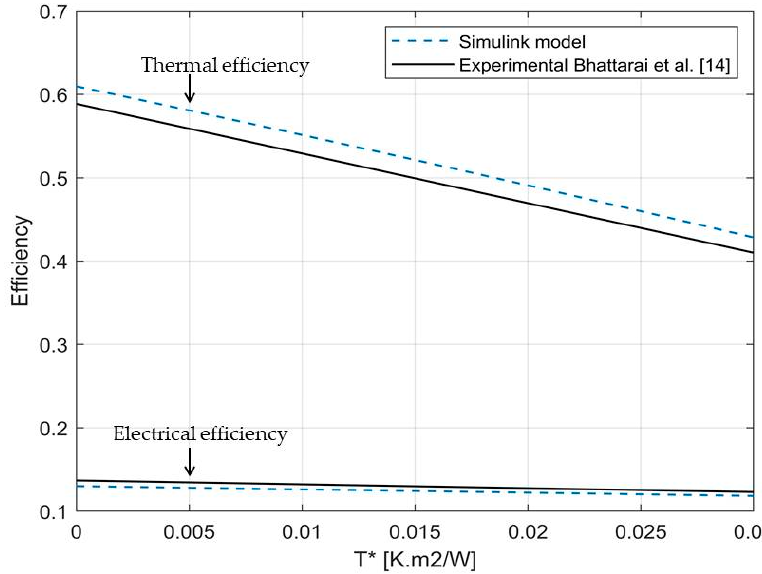
Figure 5. Simulated thermal and electrical e ffi ciencies as a function of the reduced temperature. The numerical PVT model was used to plot the variation of the electrical and thermal e ffi ciencies against the reduced temperature in Equation